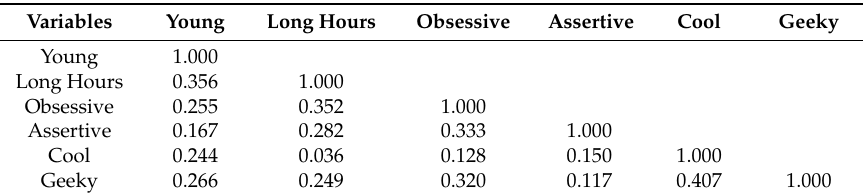
Table A2. Pearson’s Zero-Order Correlation Coefficients from Bivariate Pairs of Cultural Scale Traits Describing Successful Tech Workers (Simard et al. 2007).